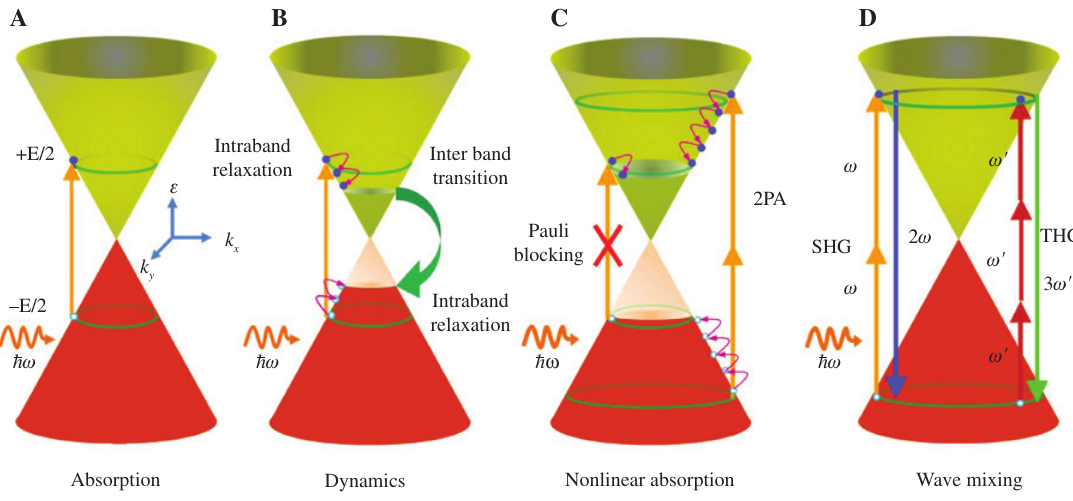
Figure 9: Energy level description for various NLO processes in graphene. (A) Schematic of photoexcitation process responsible for the absorption of light in graphene. Arrow indicates optical interband transition. (B) Relaxation dynamics of photogenerated carriers. (C) Pauli blocking and TPA process. (D) SHG (left) and THG (right) process in